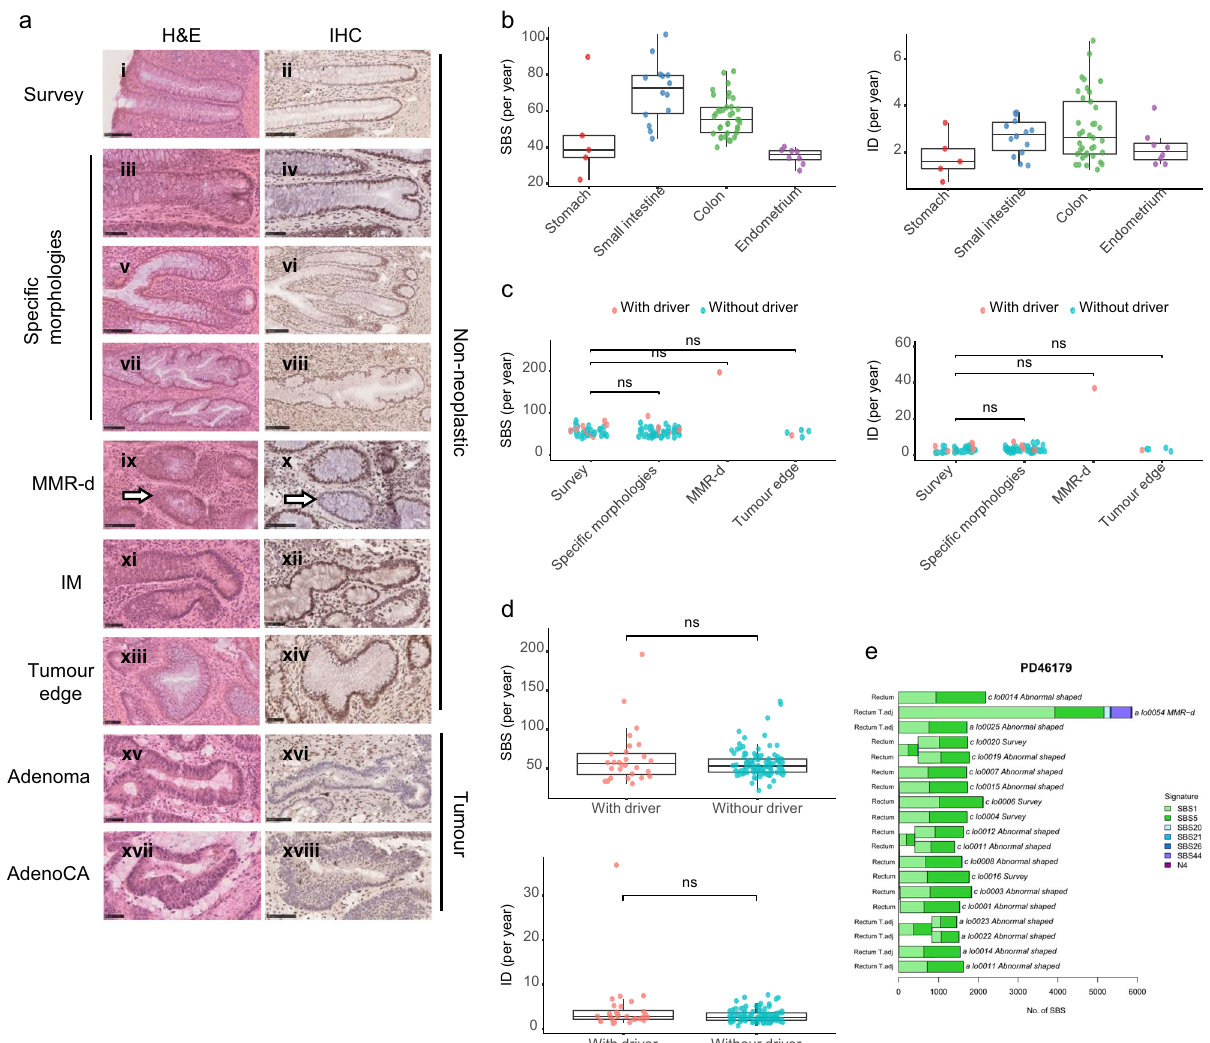
Fig. 1 Mutation burden in the non-neoplastic crypts in LS patients. a Representative images of H&E and IHC staining of crypts with different morphologies. Except for the MMR de fi cient crypt (indicated by white arrows), images of H&E and IHC did not represent the same crypt. MMR protein antibodies were used according to the germline MMR gene mutation in respective patients. MMR-d: MMR-de fi cient; IM: intestinal metaplasia; AdenoCA: adenocarcinoma. Scale bar: 100 μ m (i, ii, v, vi, vii, viii, ix, x, xvi, xviii); 50 μ m (iii, iv, xi, xii, xiii, xiv, xv, xvii). b – d Boxplots showing the 1.5X interquartile range (whiskers), the fi rst and third quartile (bounds of box), and the median (centre)of the data. Each data point represented a crypt. Two-sided Wilcoxon test: ns = non-signi fi cant. b Single base substitutions (SBS) and insertions and deletions (ID) burden of survey crypts from the stomach ( n = 5, red), the small intestine ( n = 14, blue), the colon ( n = 37, green) and the endometrium ( n = 8, purple). c SBS and ID burden in different types of colonic crypts (Survey ( n = 37), Speci fi c morphologies (n = 50), MMR-d ( n = 1), Tumour edge ( n = 5)). Crypts with and without driver mutations are indicated in pink and blue, respectively. d SBS and ID burden in non-neoplastic crypts with ( n = 28, pink) and without ( n = 104, blue) cancer driver mutations. e A phylogenetic tree showing the clonal relationship between non-neoplastic crypts in PD46179. Branch lengths correspond to the number of SBS mutations. SBS mutational signatures are mapped onto tree branches. Each crypt is annotated with its identi fi er, crypt type, and tissue